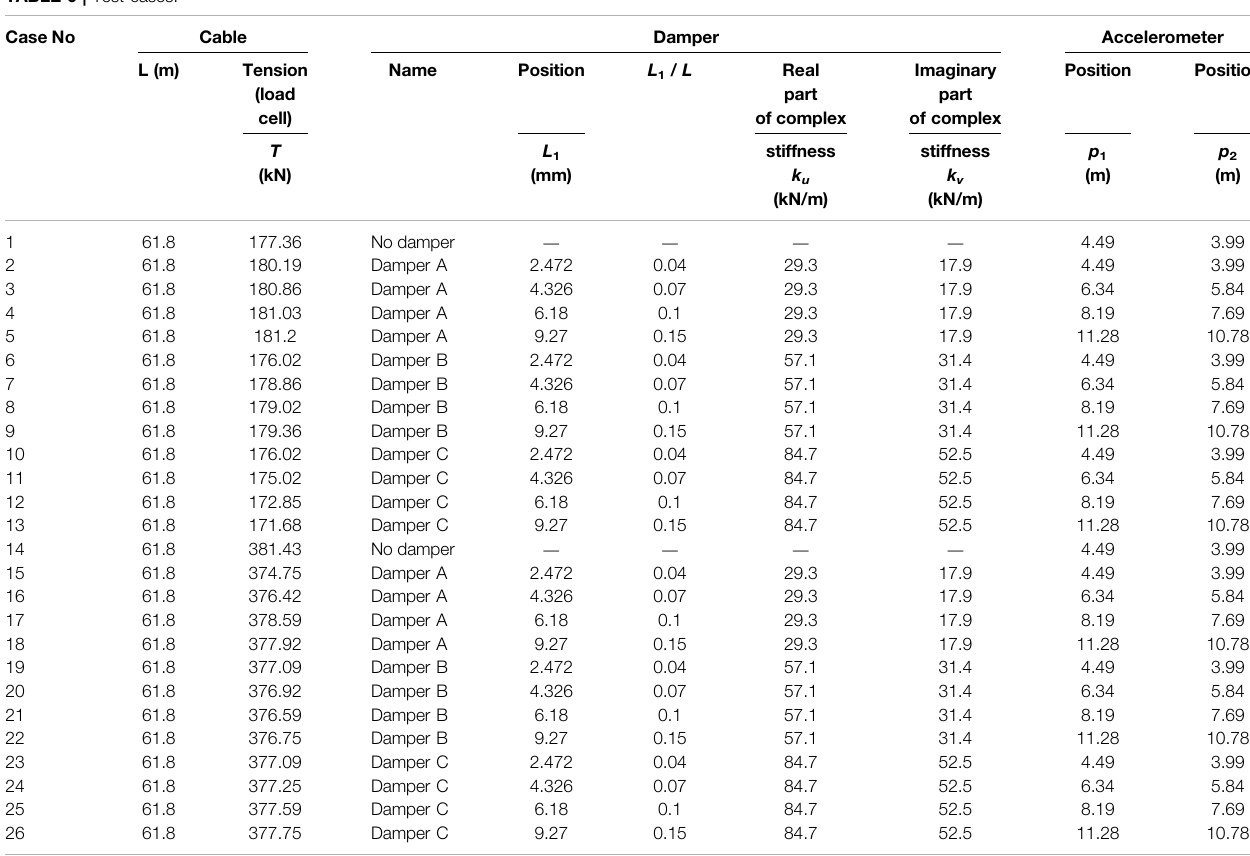
TABLE 6 | Test cases.